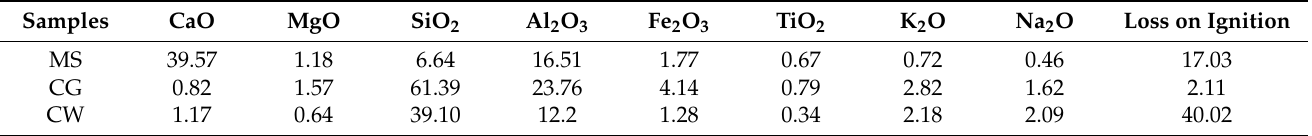
Table 2. The chemical composition of raw materials (mass fraction,